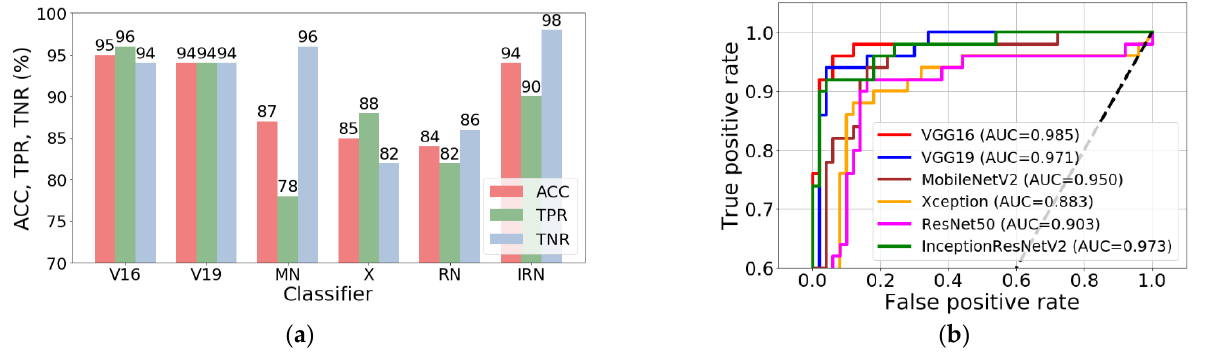
Figure 11. Plots of the training and validation accuracy during the stages of feature extraction and fine tuning: ( a ) VGG16; ( b ) VGG19; ( c ) MobileNetV2; ( d ) Xception; ( e ) ResNet50; and ( f ) Inception-ResNetV2.